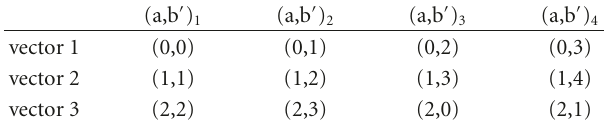
Table 5: Writing with permutation.